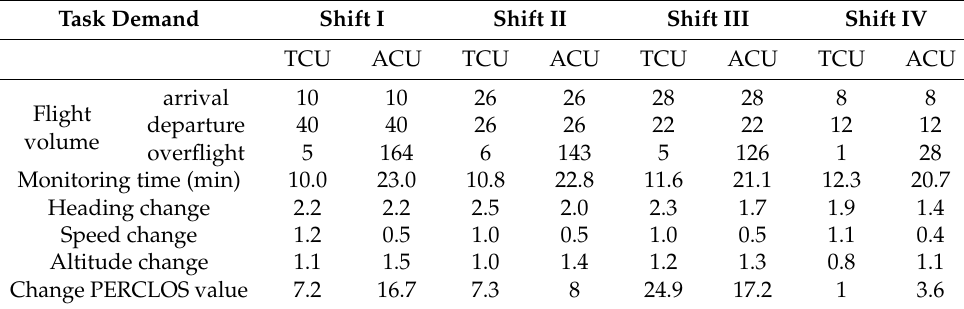
Table 7. Comparing task demands and ATCOs’ fatigue changes in the TCU and